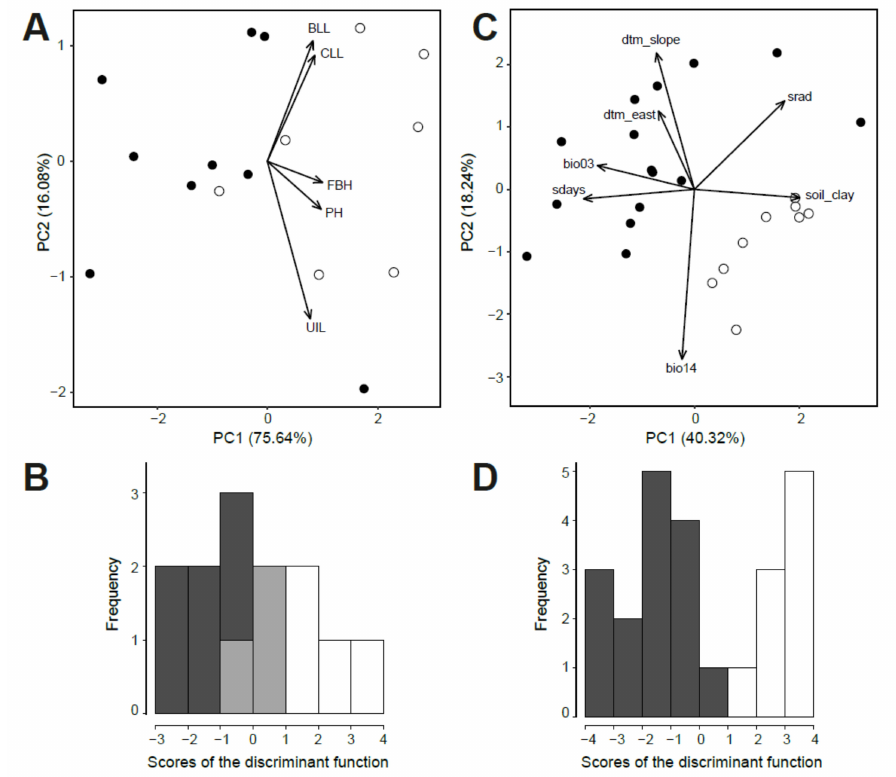
Figure 5. Morphological and environmental differentiation between diploid (black) and tetraploid (white) populations of Dianthus sylvestris subsp. sylvestris , with their overlap in B shown in grey. ( A ) Principal component analysis (PCA) and ( B ) histogram of discriminant analysis (DA) based on five morphological characteristics. ( C ) PCA and ( D ) histogram of DA based on seven environmental variables. Characteristic abbreviations in ( A , C ) are explained in Tables S2 and